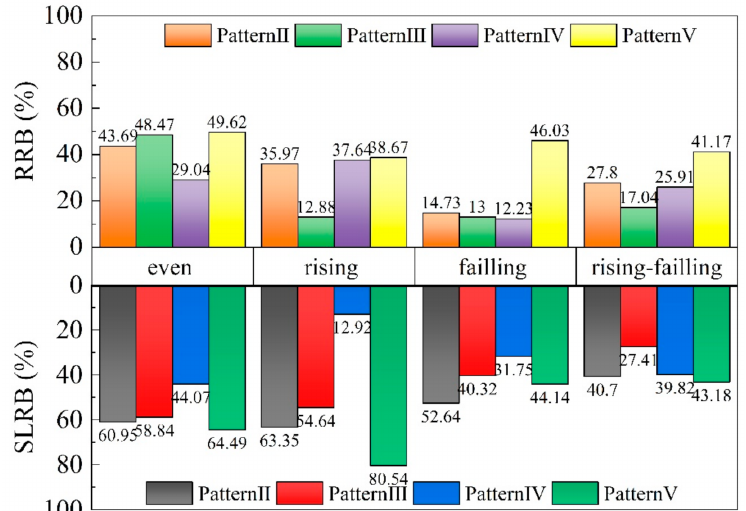
Figure 8. RRB and SLRB under different grass strip and inflow rate patterns.